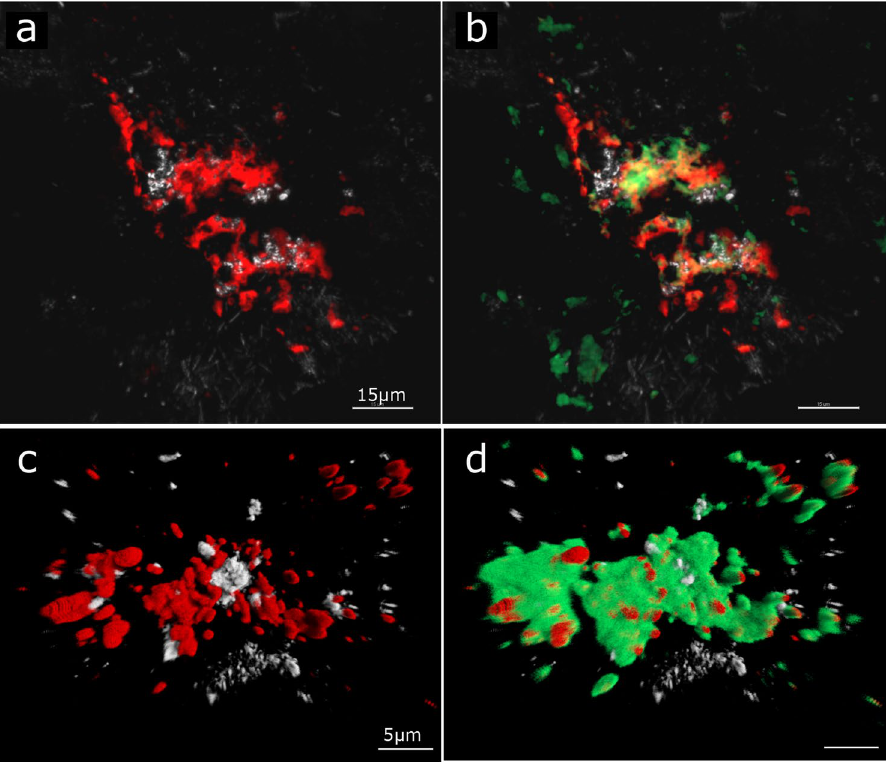
Figure 2. Bacterial biofilms detected at 414,8 mbs by CARD-FISH ( a and b ) and FISH ( c and d ). In red, EUB338 I-III probe signal; in green, FITC-ConA lectin signal. Scale bar: a and b 15 μ m, c and d 5 μ m.